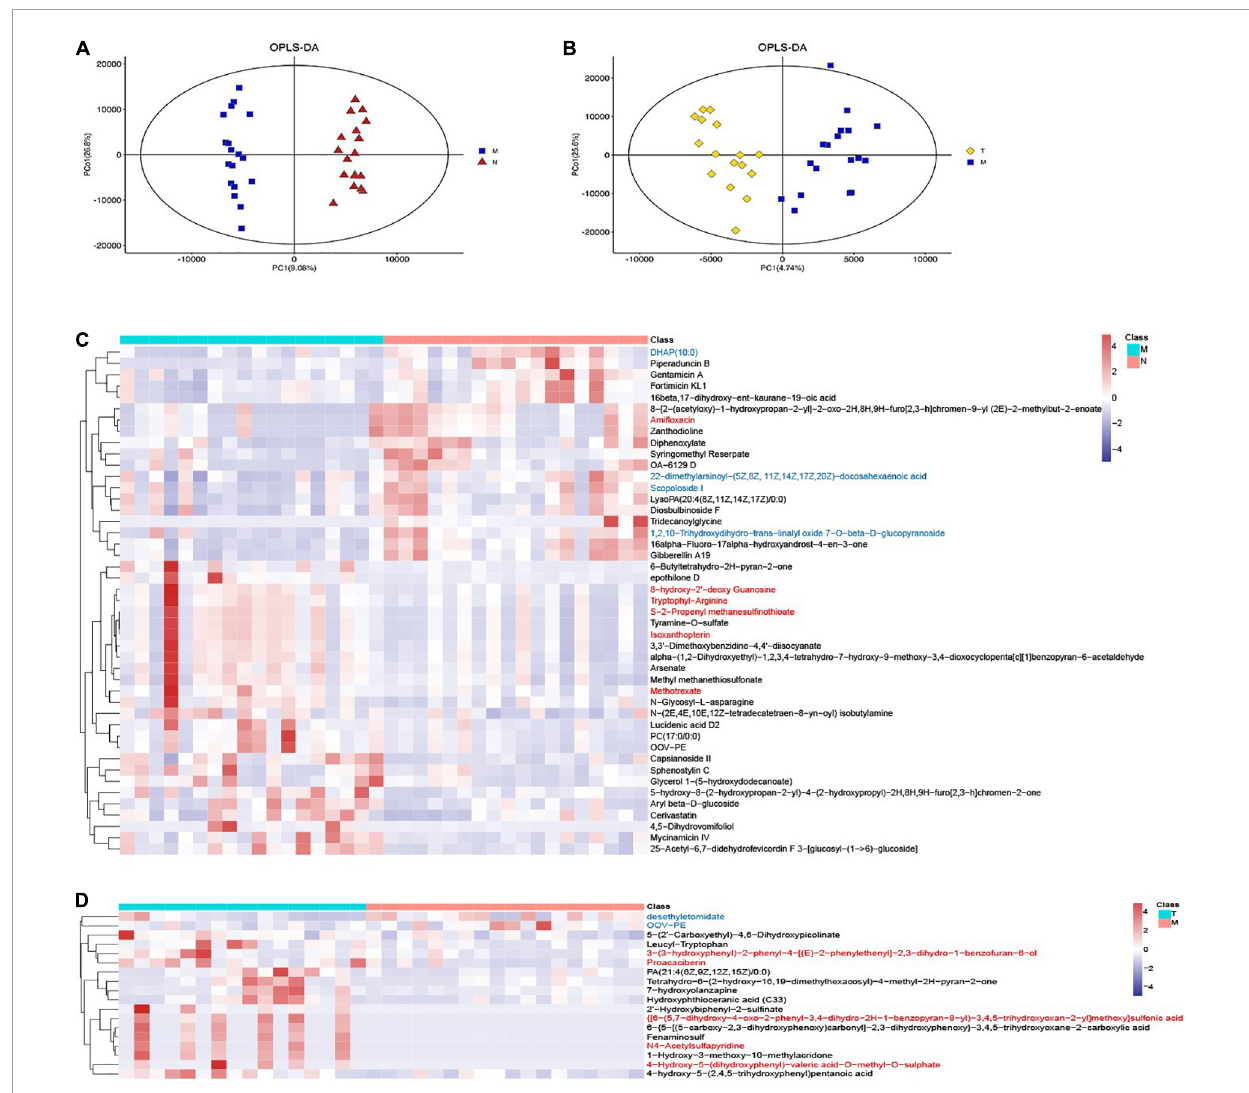
FIGURE2 OPLS-DA and heatmaps show differentially expressed saliva metabolites. The OPLS-DA images indicated differentially expressed metabolites in MPASD patients (A) and after acupuncture intervention (B) heatmaps show the differentially expressed saliva metabolites in MPASD patients (C) , and after acupuncture intervention (D) the top VIP significantly upregulated (red) and downregulated (blue) metabolites.